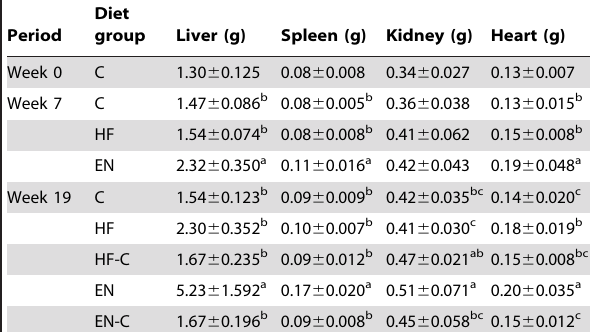
Table 1. Organ masses.